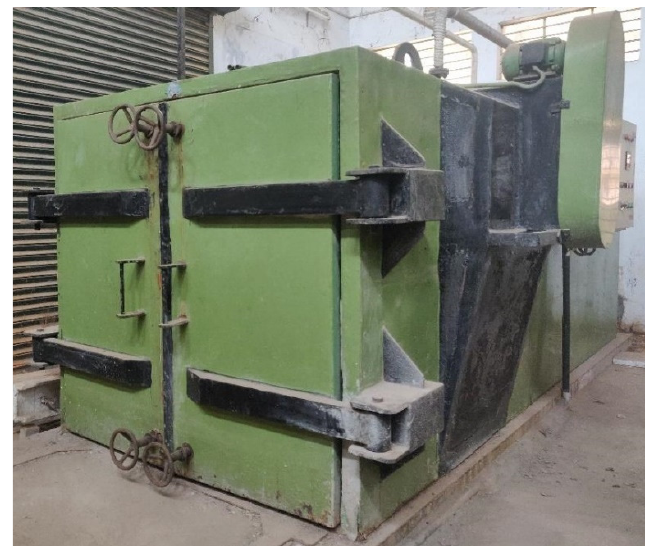
Figure 3. Steam curing chamber.